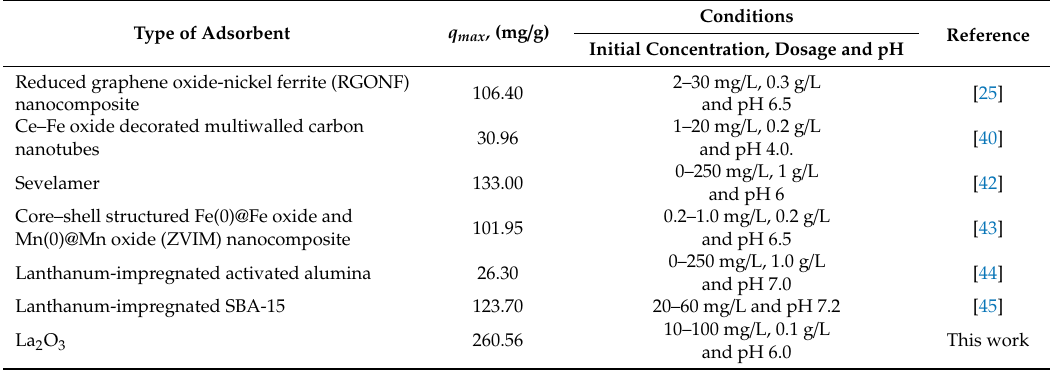
Table 3. Comparison of As(V) adsorption capacities of various adsorbents. Type of